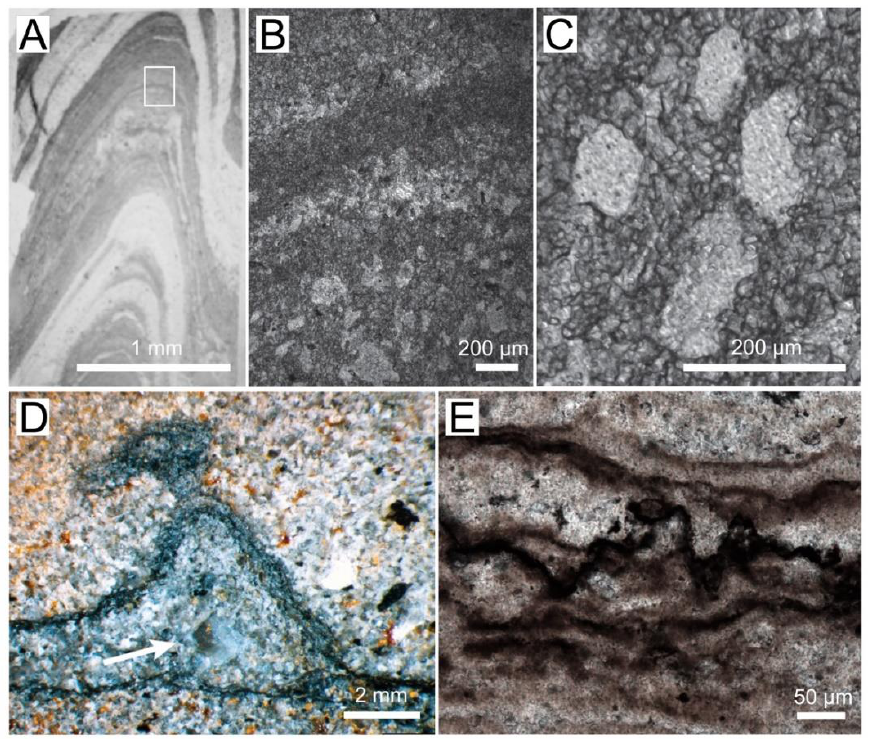
Figure 1. Textures in Archaean and Proterozoic microbial mats and stromatolites. ( A ) Photograph of a thin section of conical stromatolite from the 3 Ga Chobeni Formation, South Africa. The light areas contain silica, and the dark laminae contain dolomite. White rectangle outlines the area enlarged in panel ( B ). ( B ) Photomicrograph of laminae preserved by microcrystalline and microsparitic dolomite (dark). The lighter laminae contain pores filled by silica. ( C ) Enlarged view of silica-filled pores surrounded by 10–100 mm–thick dolomite laminae. ( D ) Photograph of a polished slab showing a tufted silicified mat in a sandstone from the Archean Moodies Group, South Africa [25]. The arrow points to a silica-filled void. (Reprinted with permission from ref. [25]. Copyright 2015 Elsevier) ( E ) Photomicrograph of the dark, organic-rich layers in a pustular silicified mat from the ~1600 Ma Proterozoic Balbirini Dolomite, Australia.